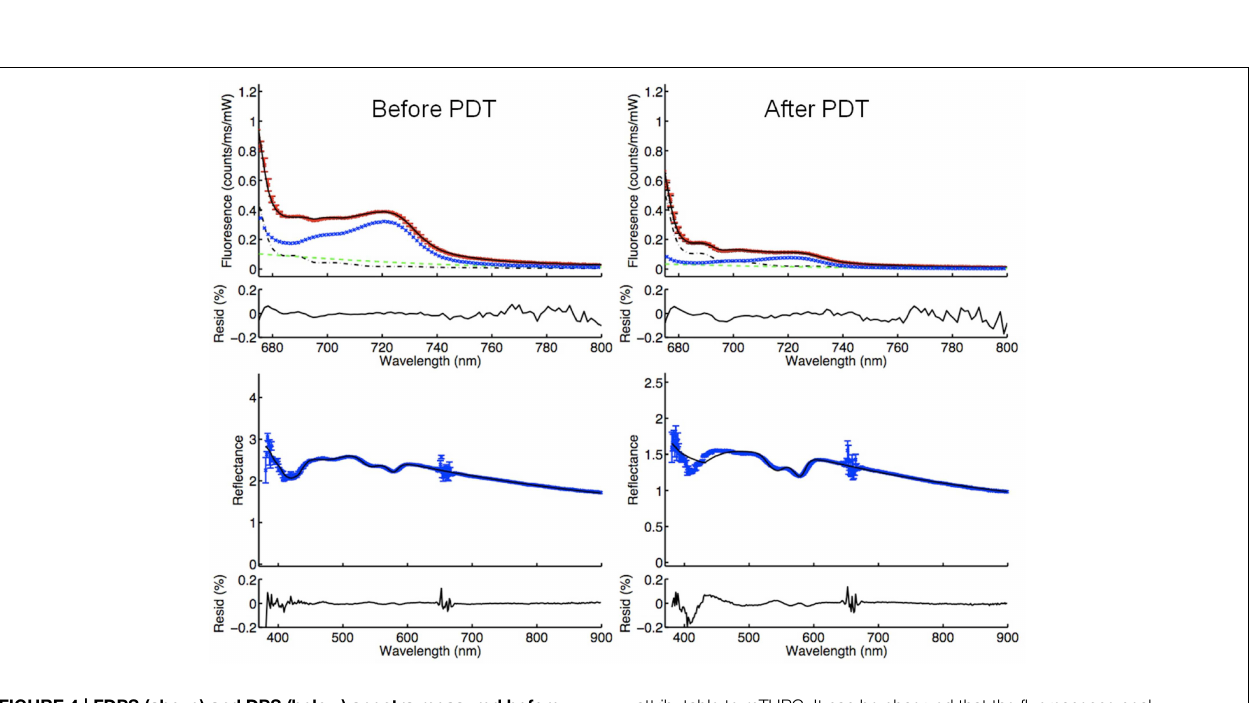
attributable to mTHPC. It can be observed that the fluorescence peak between 700 and 740nm wavelength decreases due to breakdown of mTHPC during